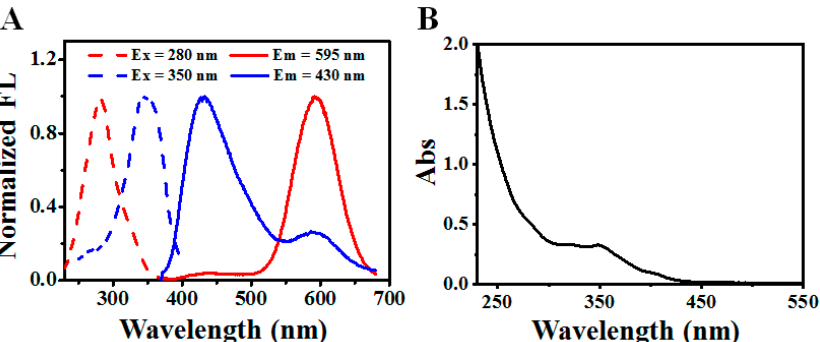
Figure 2. Fluorescence excitation and emission spectra ( A ) and UV-vis absorption spectra ( B ) of as-prepared DE-Au NCs.